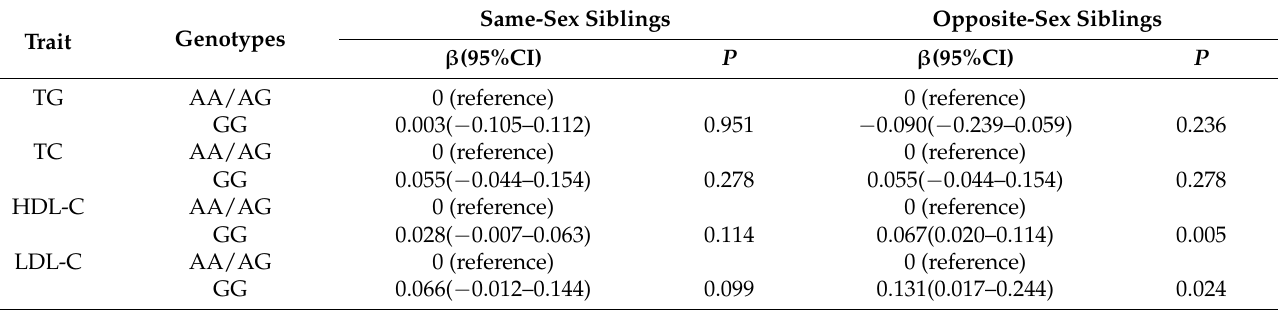
Table 4. Effects of the alter rs182052 genotypes on ego lipid levels stratified by sex difference.